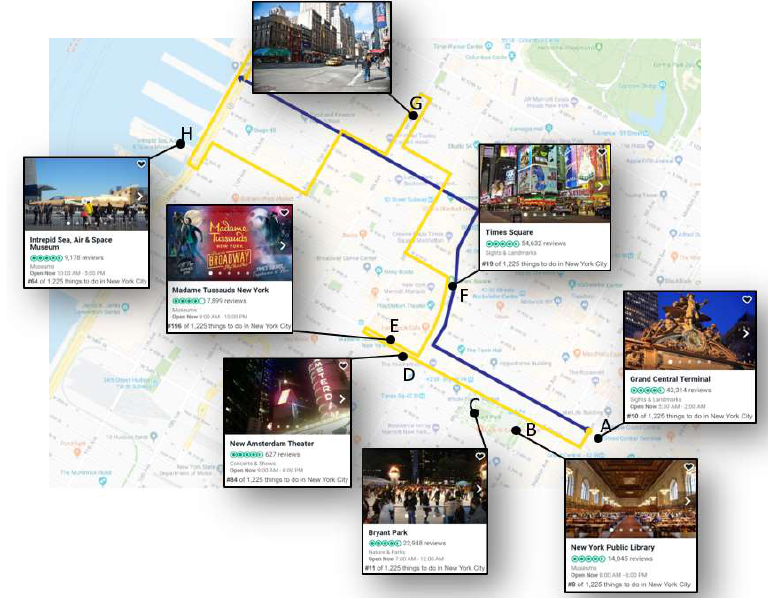
Figure 7. Manhattan walking routes: tourism (yellow) and shortest (via Google Maps) (blue). Identified landmarks and attractions along the tourism route (with TripAdvisor ranking where exists): Grand Central Terminal (A), New York Public Library (B), Bryant Park (C), New Amsterdam Theatre (D), Madame Tussauds New York (E), Times Square (F), Hell’s kitchen (G), Intrepid Sea, Air & Space Museum (G) (background: Google